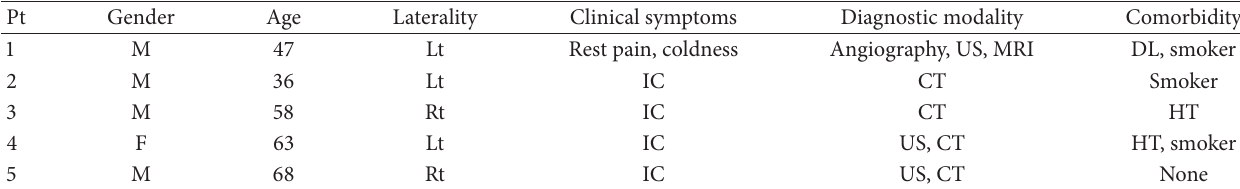
Table 1: Patients characteristics.